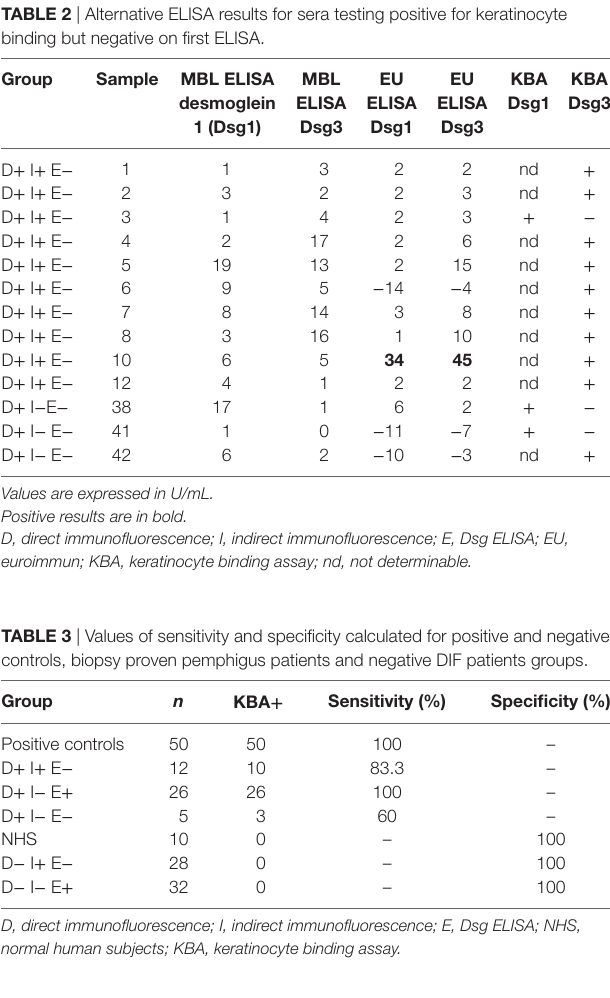
TaBle 2 | Alternative ELISA results for sera testing positive for keratinocyte binding but negative on first ELISA. group sample MBl elisa desmoglein 1 (Dsg1)